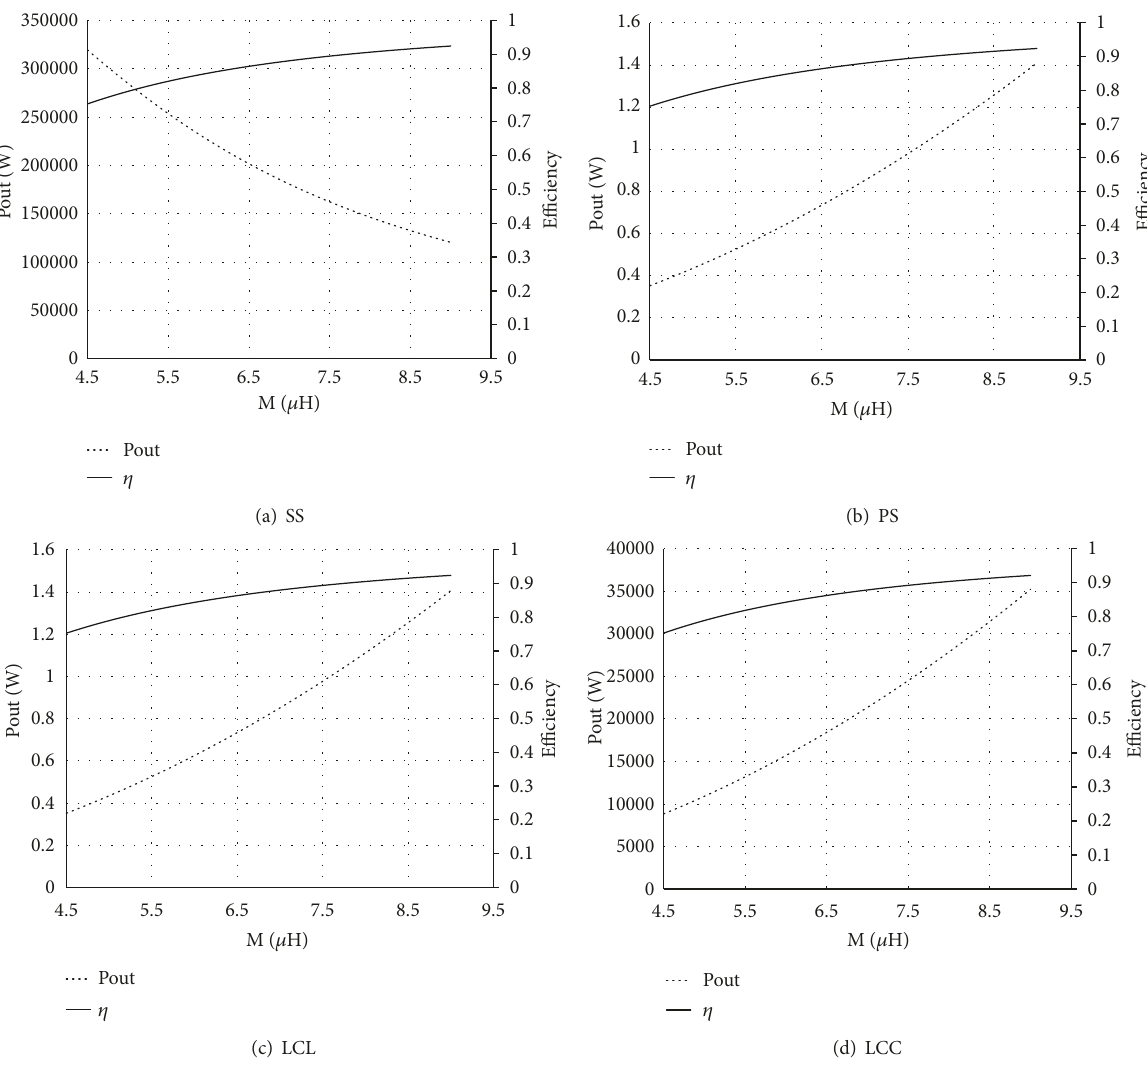
Figure 5: Output power and efficiency vary with mutual inductance.